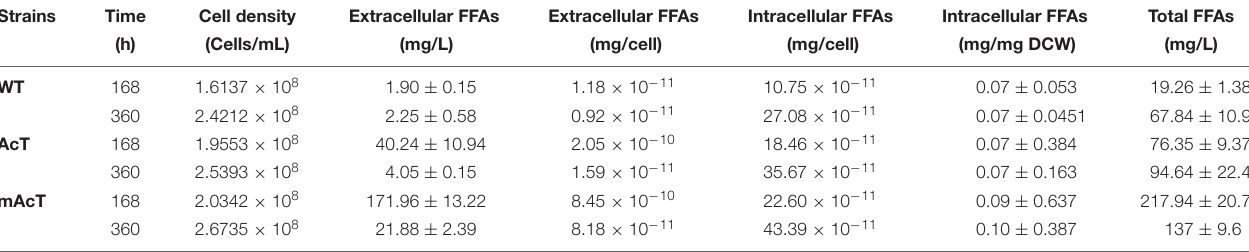
TABLE 1 | The secreted extracellular and intracellular FFAs calculation.